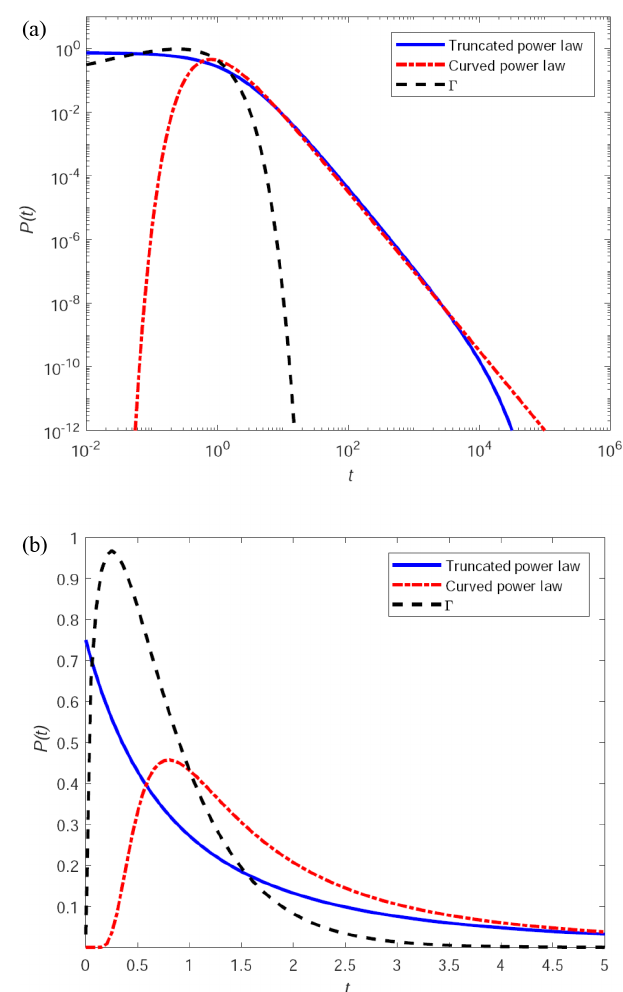
Figure 7. Truncated power law, curved power law (inverse gamma distribution) and gamma distribution, for the specific parameters: β = 1 . 5, t 1 = 1, t 2 = 10 3 , t ∗ = t 1 . (a) Log–log scale to emphasize the long-term tailing behaviour. (b) Linear